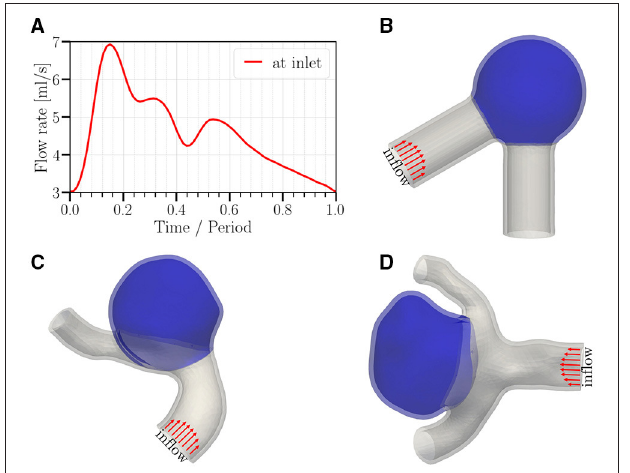
FIGURE 1 | (A) Temporal variation of the imposed flow rate at the inlet (period T = 0.6 s or 0.8 s, depending on the studied case). (B–D) Geometries studied in this work; (B) a canonical aneurysm model based on data in ( Usmani and Muralidhar, 2018; Chassagne et al., 2021 ); (C,D) patient-specific cerebral aneurysm models based on the cases C0034 and C0020 in the open-source Aneurisk dataset repository ( Aneurisk-Team, 2012), respectively. In order to keep the computational cost in a reasonable range, we select a short representative section from each full image available in the Aneurisk repository. All meshes use quadratic tetrahedrons having a mean effective spatial resolution of 0.07 mm. Arrows serve to highlight the parabolic velocity profile imposed at the inlet. The tissue degradation model is applied only on the aneurysmal region (colored in blue); the remaining of the vessel (gray) is modeled as Neo-Hookean.